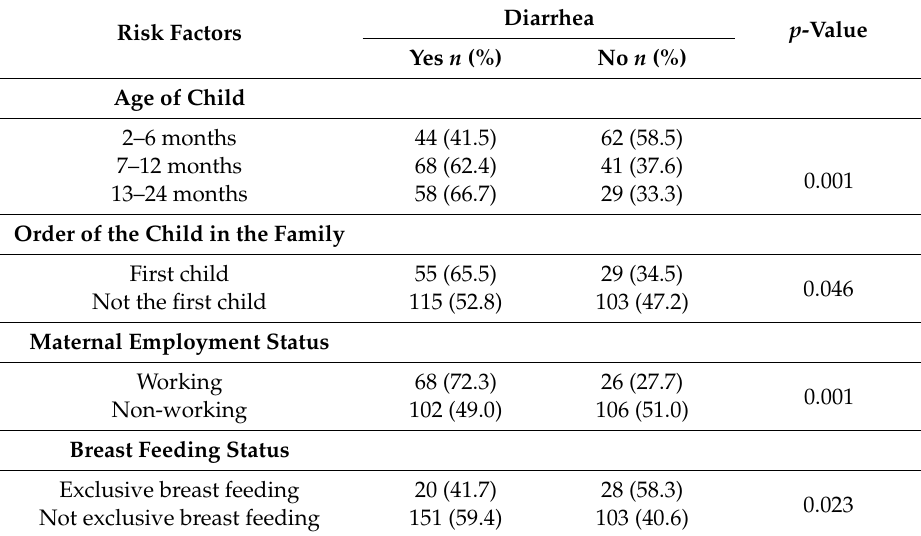
Table 4. Factors associated with childhood diarrheal